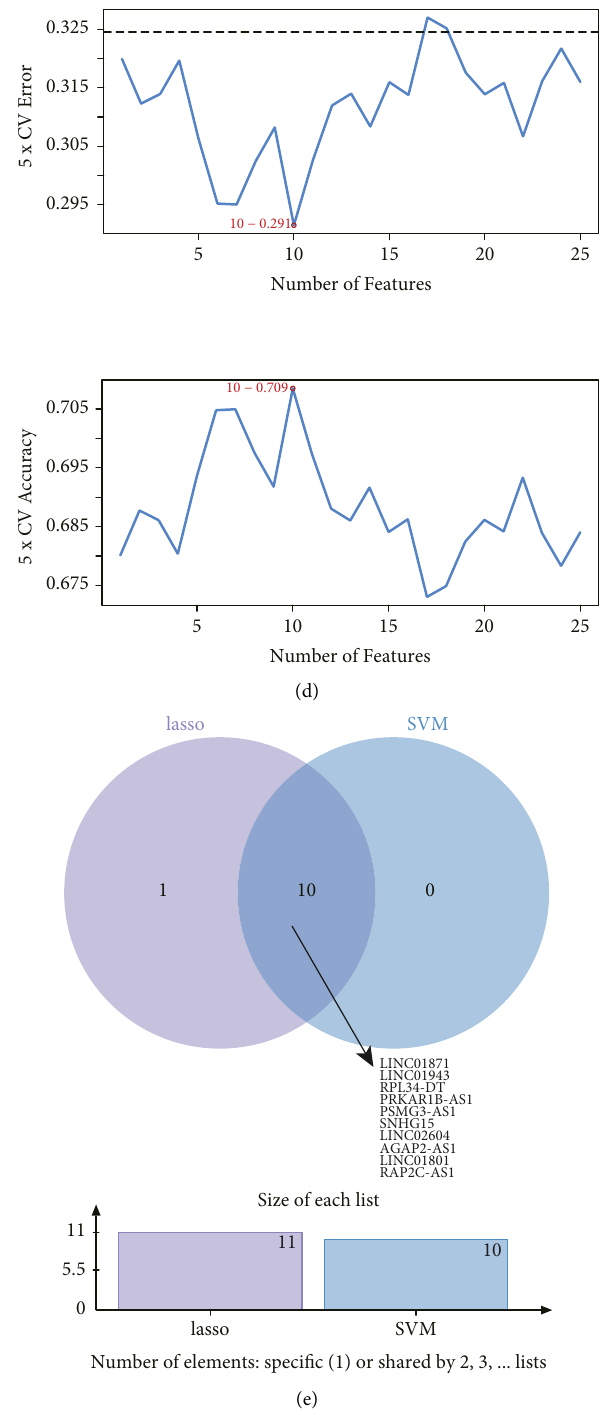
Figure 2: LncRNA for the determination of the prognostic value in KIRC. (a) Process of model parameter selection during the use of the Lasso method. (b) Dose K-fold cross-validation for the Lasso model to select model parameters. (c) Comparison graph corresponding to the 1se model and min model in Lasso. (d) Feature graph of the optimal solution for feature selection during the use of the SVM algorithm. (e) Venn graph representing gene intersection between the Lasso model and the SVM